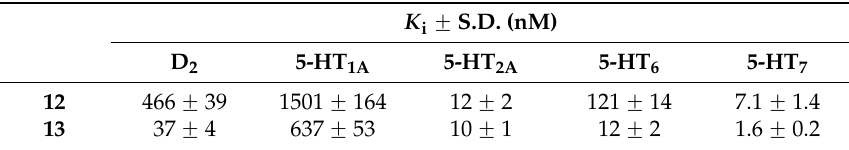
Table 6. Extended results for compounds 12 and 13